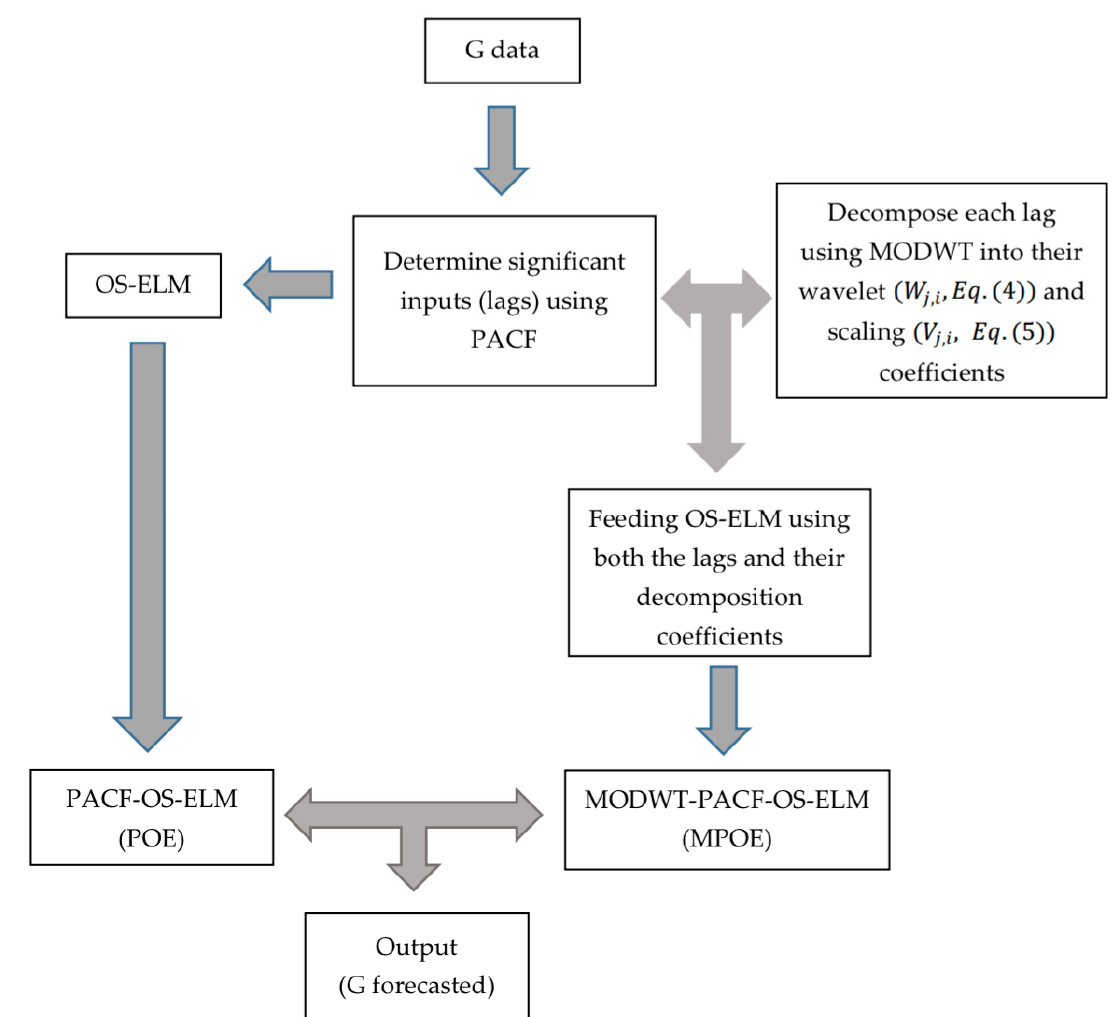
Figure 1. Flowchart showing the model development stages.